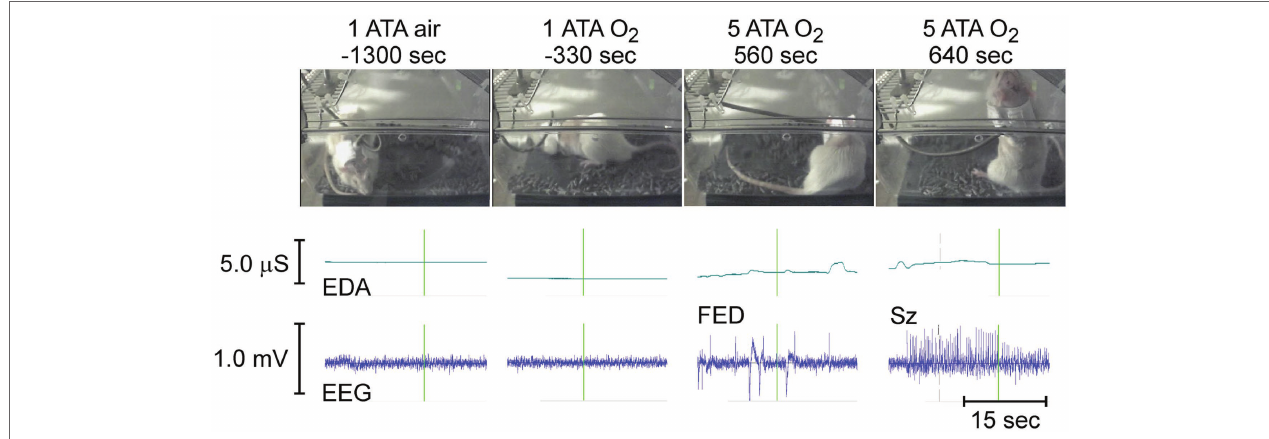
FIGURE 8 | (top to bottom). Animal behavior, EDA, and cortical EEG activity in a rat before (1 ATA air and O 2 ) and during exposure to HBO 2 (5 ATA O 2 ). The times demarcated by the vertical green lines in EDA and EEG traces mark the time of the accompanying video